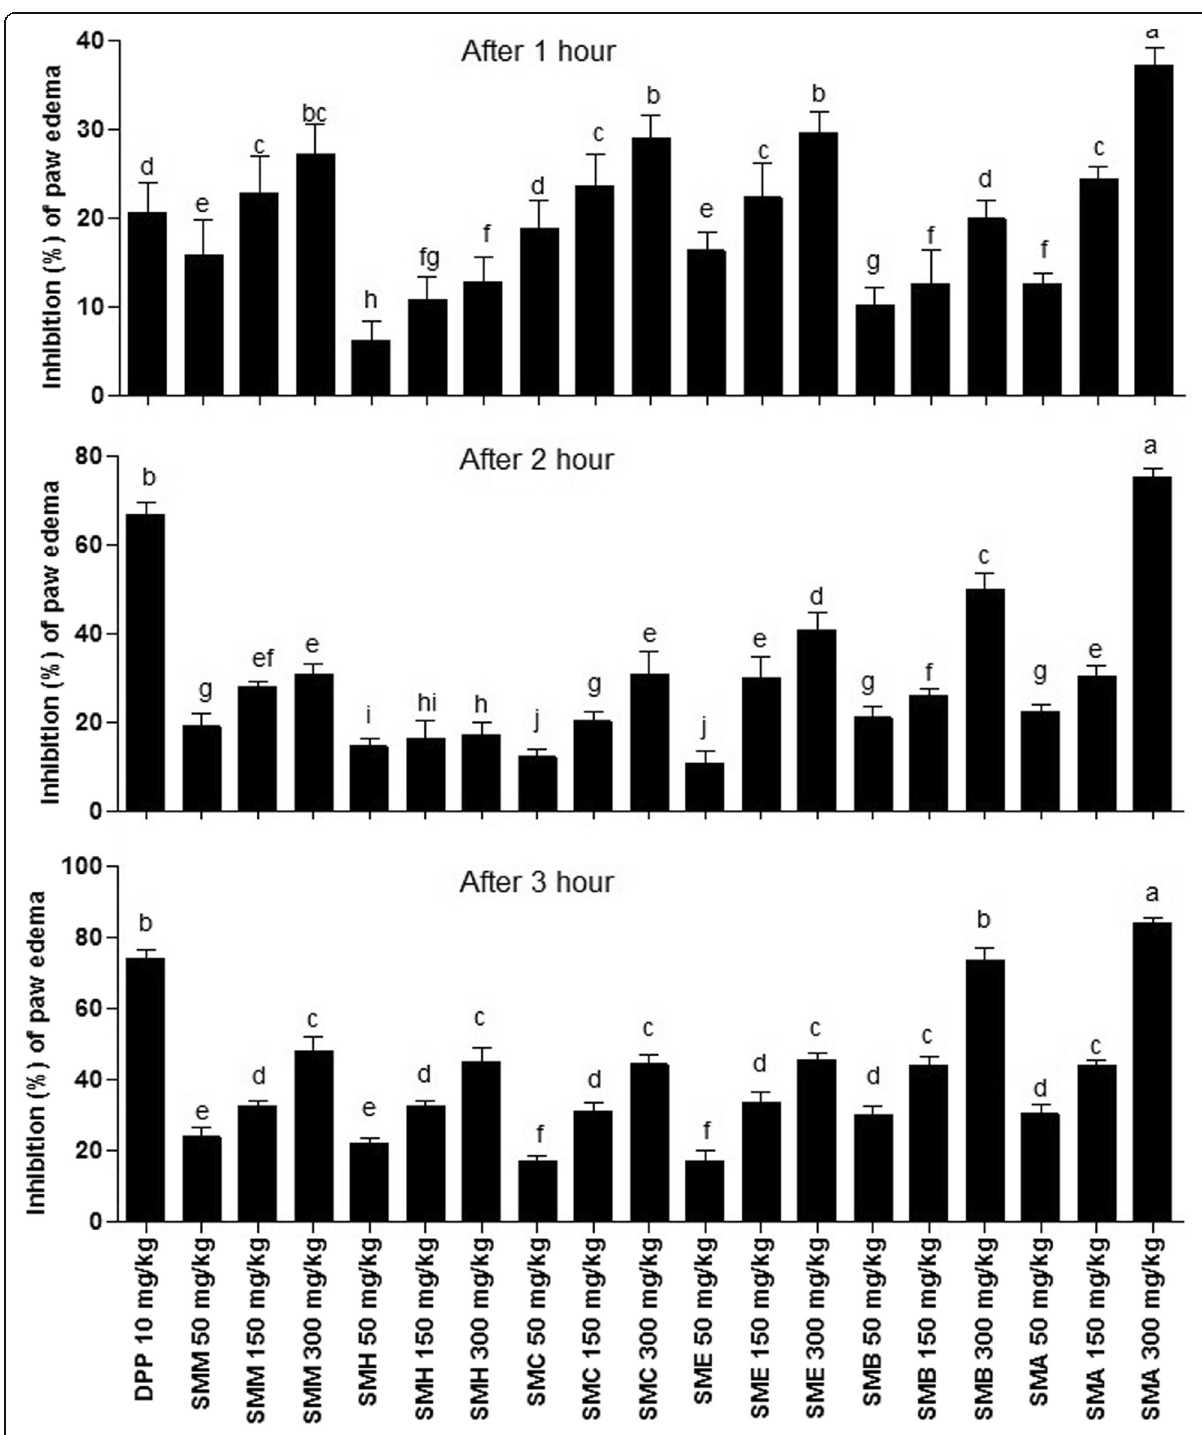
Fig. 4 Percent inhibition of carrageenan induced paw edema in rat. Each bar represents as Mean ± SD (n = 3). Superscript ( a-j ) indicate significance at P < 0.01. DPP, diclofenac potassium; SMM, S. mukorossi methanol extract of stem bark; SMH, n-hexane fraction of SMM; SMC, chloroform fraction of SMM; SME, ethyl acetate fraction of SMM; SMA, soluble residual aqueous fraction of